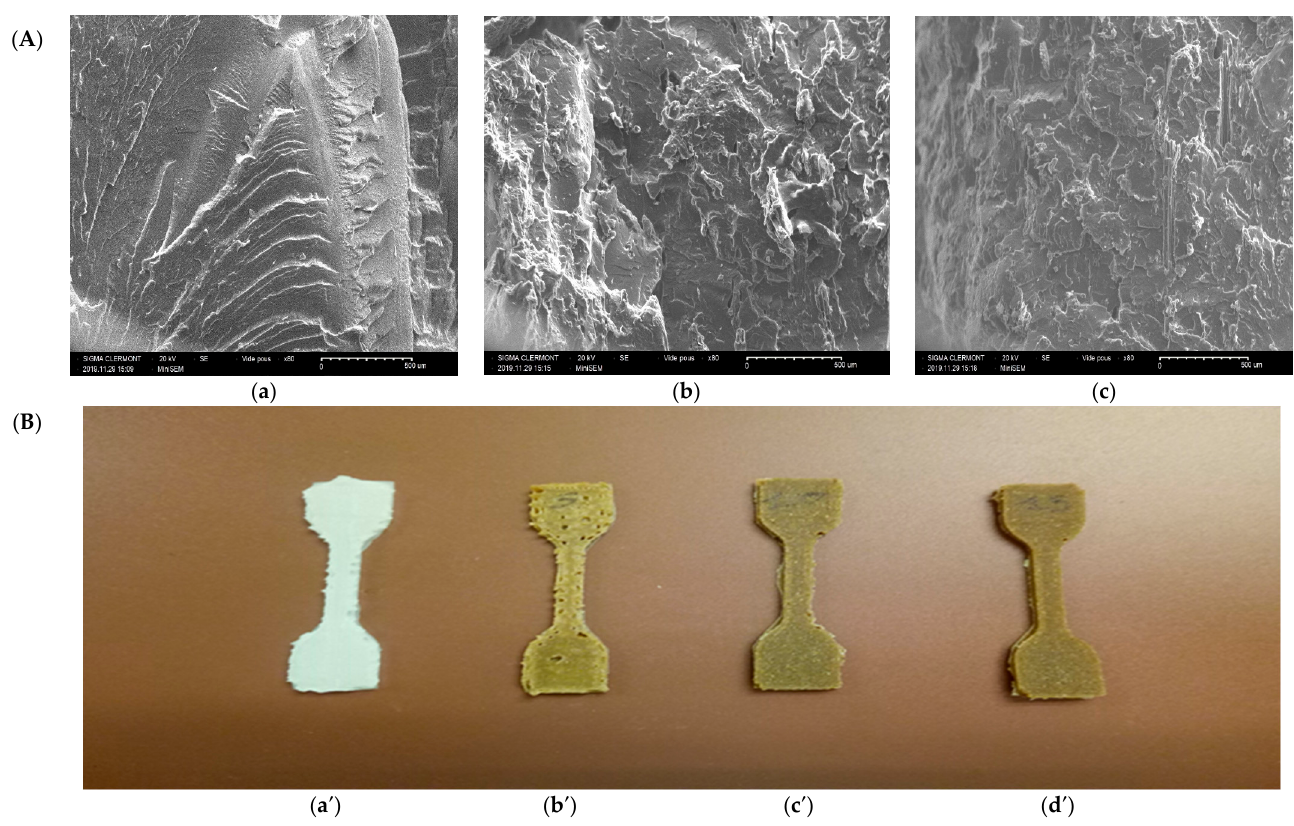
Figure 4. ( A ): SEM micrographs of biocomposites. ( a ) PBSA/5 TT, ( b ) PBSA/10 TT, and ( c ) PBSA 15 TT. ( B ): Printed specimens of virgin PBSA and biocomposites. ( a ′ ) PBSA, ( b ′ ) PBSA/5 TT, ( c ′ ) PBSA/10 TT, and ( d ′ ) PBSA/15 TT.